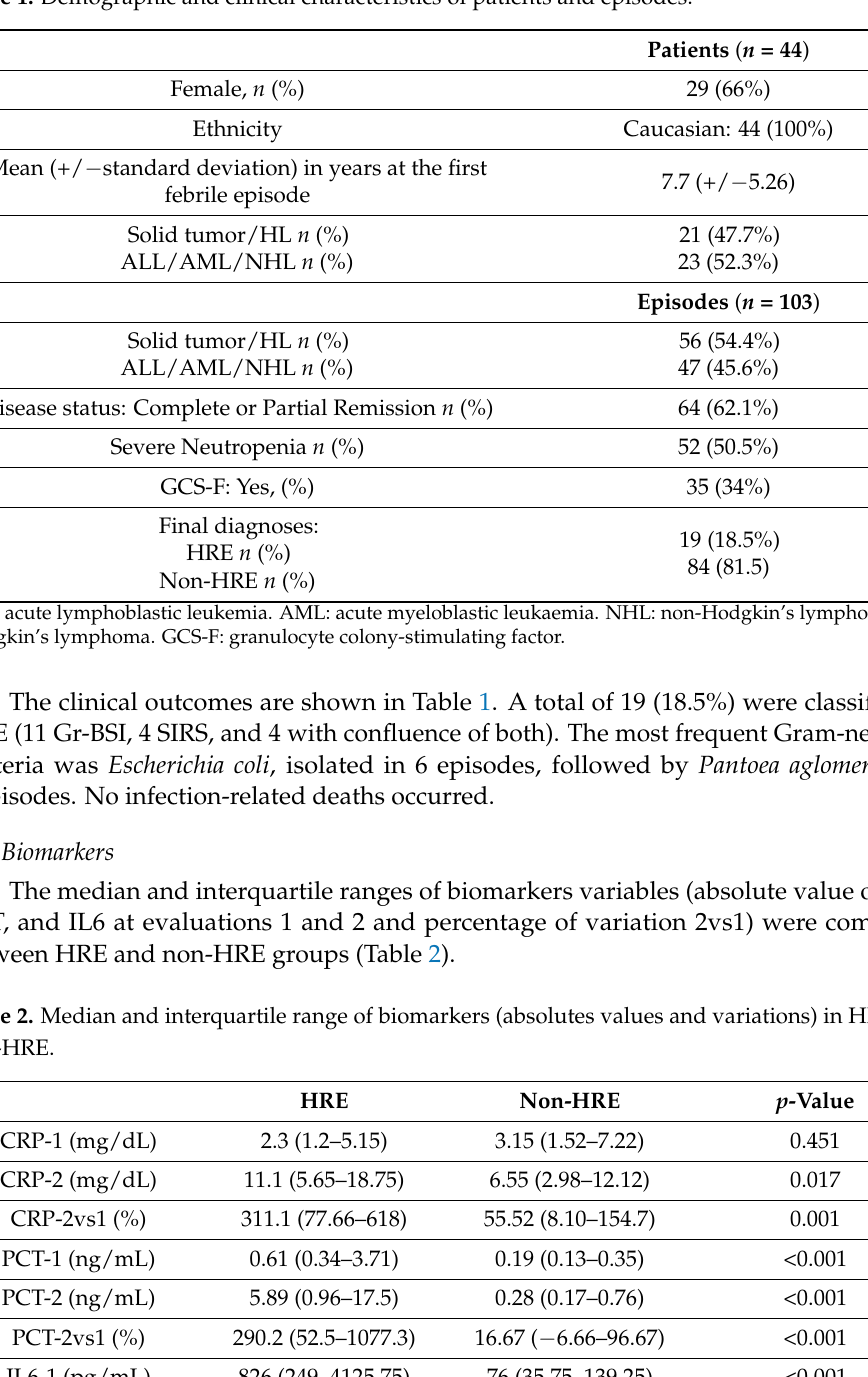
Table 1. Demographic and clinical characteristics of patients and episodes.